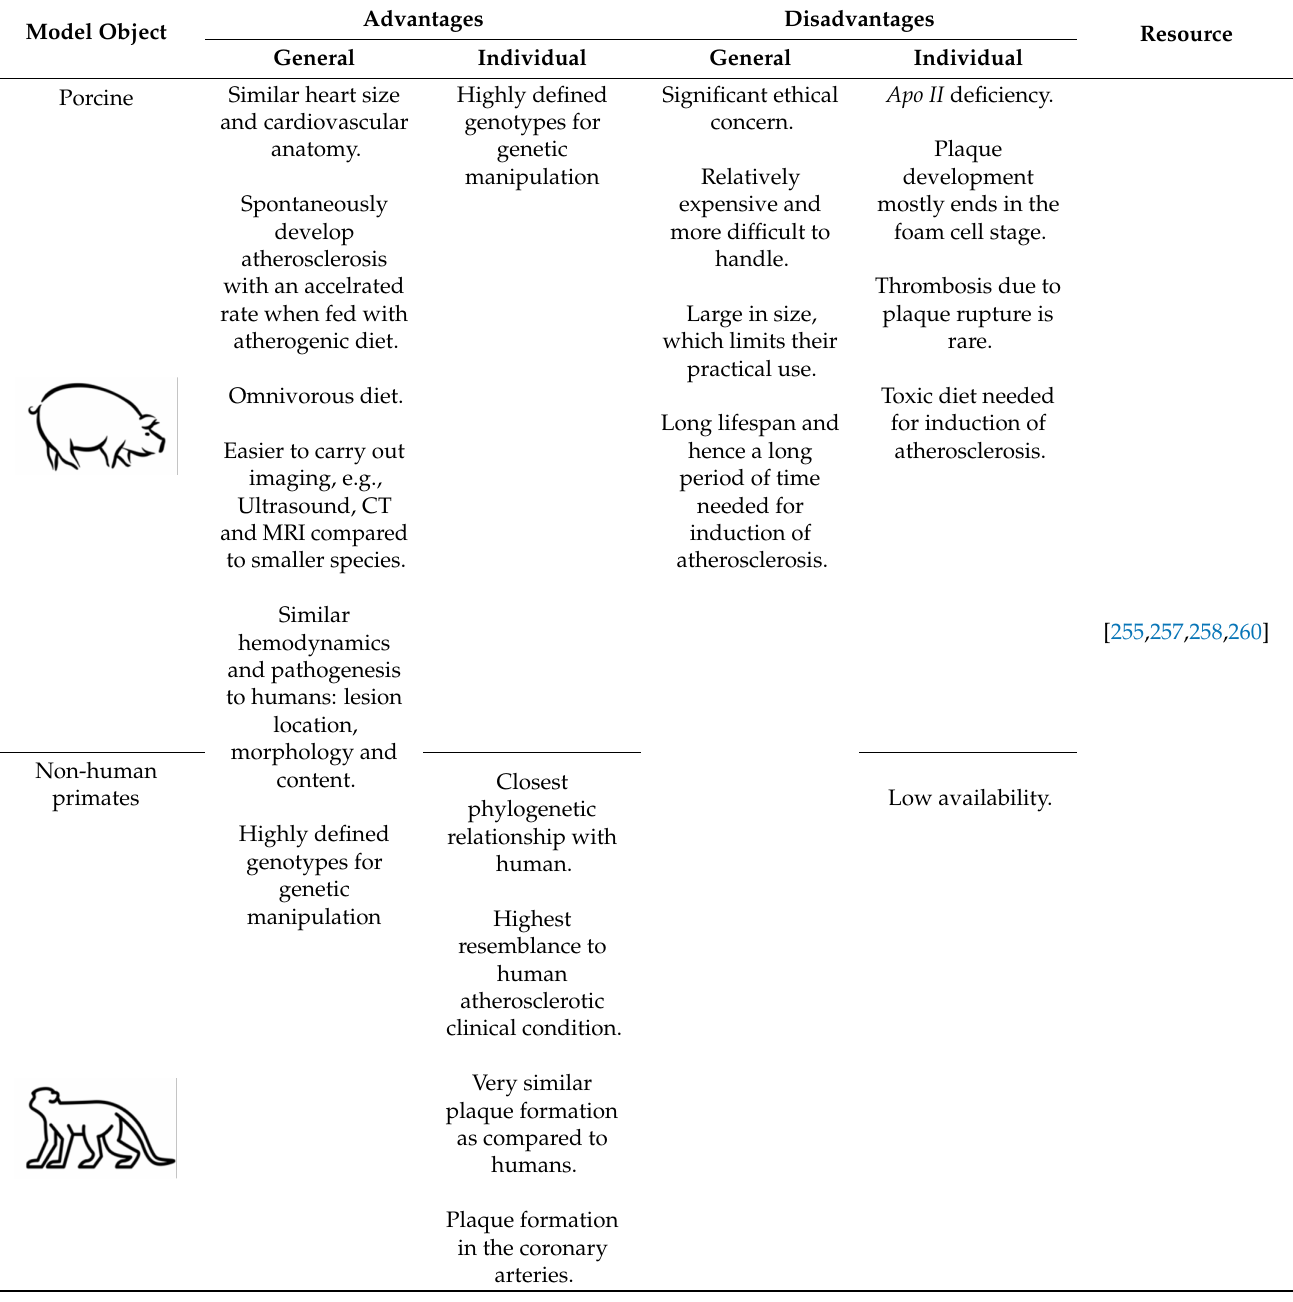
Table 5. Large animals used as models to study the relationship between atherosclerosis and nutrition. Model